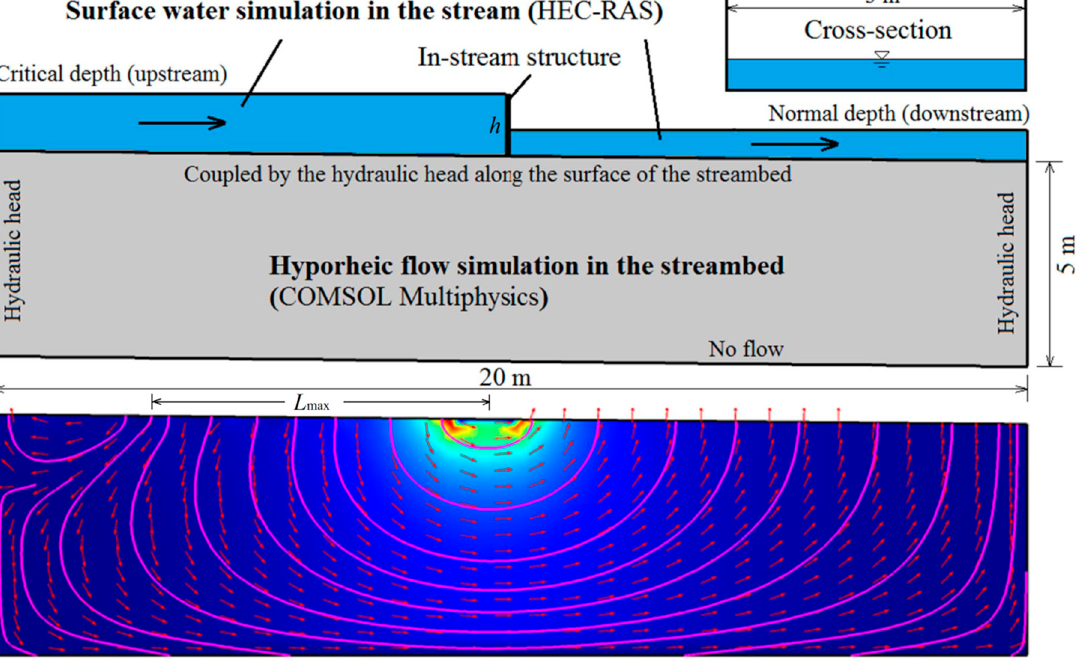
Figure 1. Numerical model and results. The illustration on the top right corner shows the cross-section for surface water simulation. The pink lines in the bottom figure indicate the flow paths and the red arrows indicate the hyporheic flux.